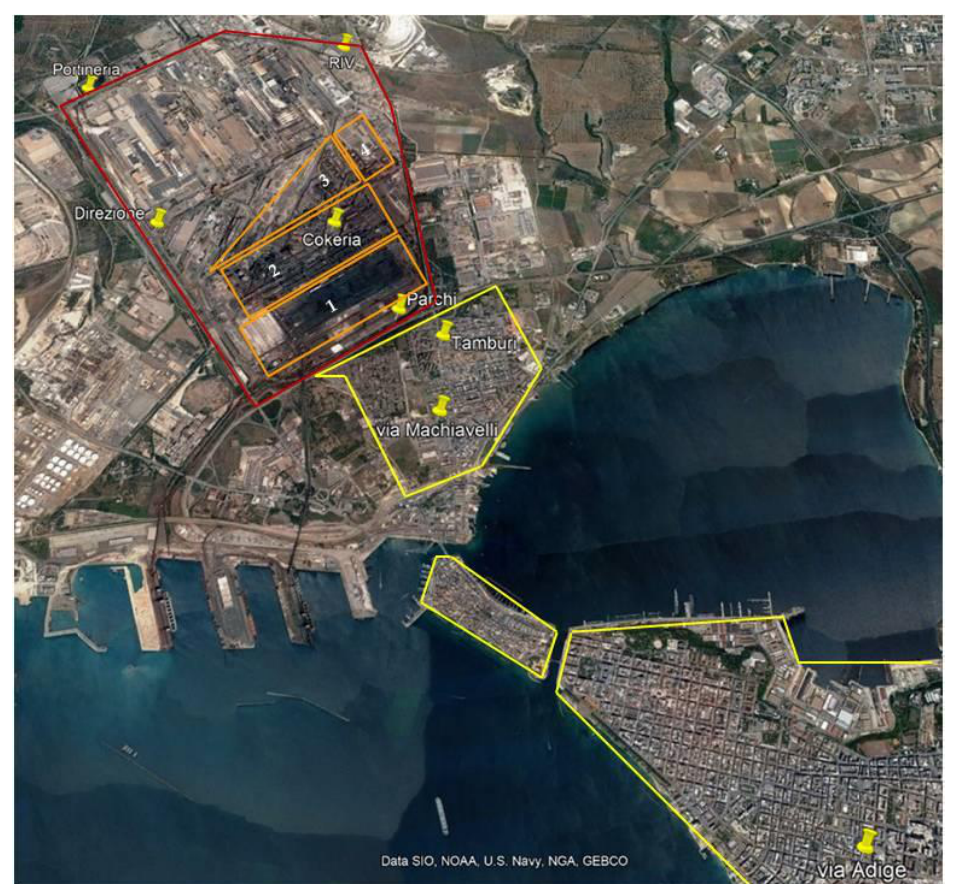
Figure 1. Position of the steel plant (delimited by the red line) with respect to the urban settlements (delimited by the yellow line). Indication of the monitoring stations inside and surrounding the steel plant and the main sectors inside the steel plant (each sector defined by the orange line). Inside the steel plant perimeter (red line): 1: mineral park; 2: coke ovens; 3: blast furnaces; 4: sintering plant.